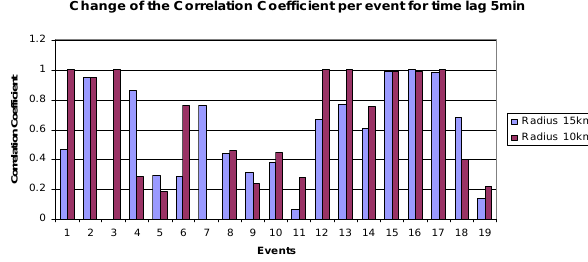
Fig. 10. The correlation coefficient for each event with a radius of 10 km (in purple) and with a radius of 15 km (in blue) and a time lag of 15 min.